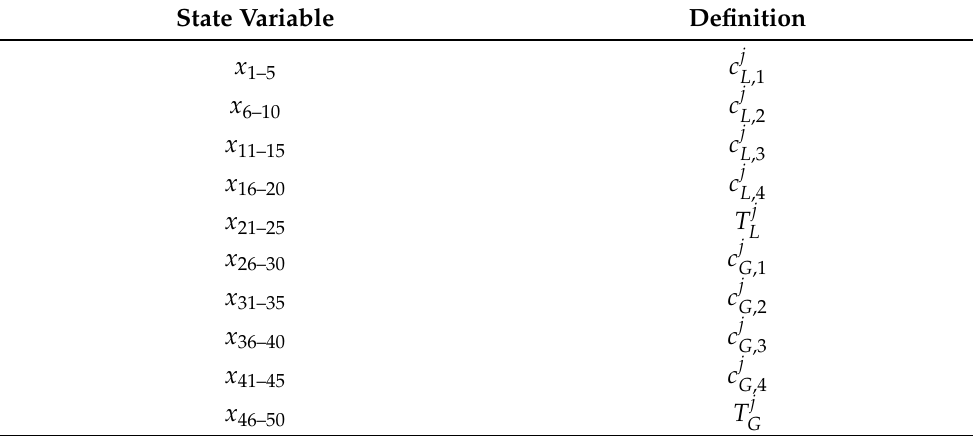
Table 1. Definition of the state variables at the jth discrete point ( j = 1,2, · · · ,5). N 2 = 1, CO 2 = 2, MEA = 3, H 2 O =